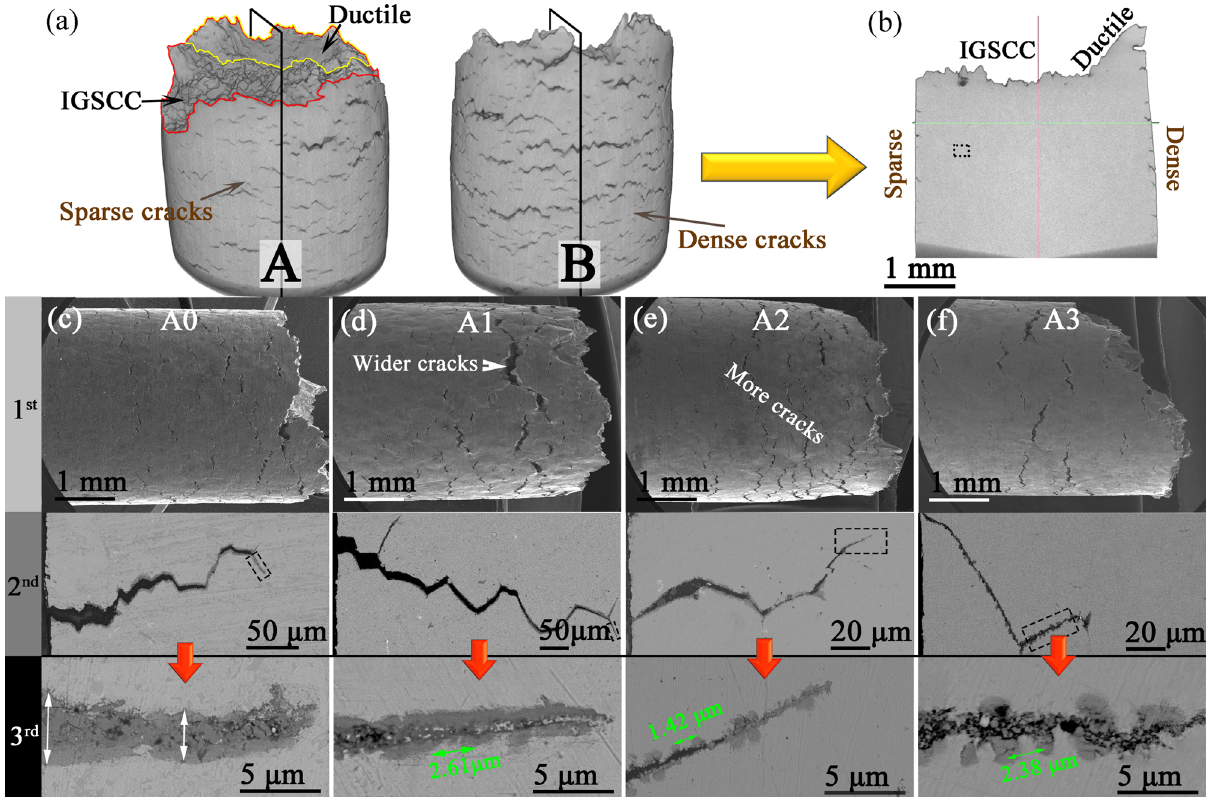
Fig. 9 Feature of surface microcracks. a Surface microcracks of A2 sample observed from different angles, b schematic diagram of cross- section processing, surface microcracks observed from the top and the cross-section of ( c ) A0 sample (0Al – 0.6Nb), d A1 sample (2.5Al – 0.6Nb), e A2 samples (3.5Al – 0.6Nb), f A3 samples (3.5Al –